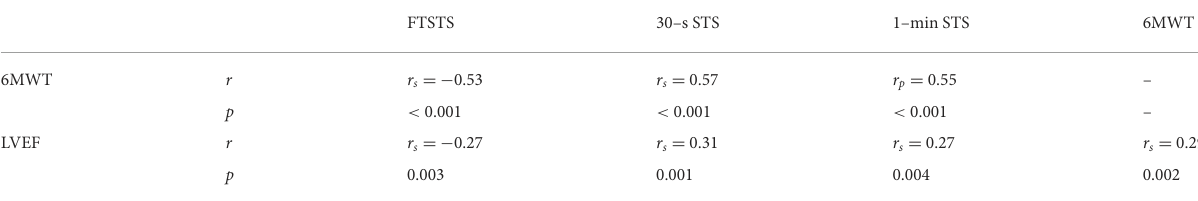
TABLE 4 Correlation analysis between STS tests with 6MWT and